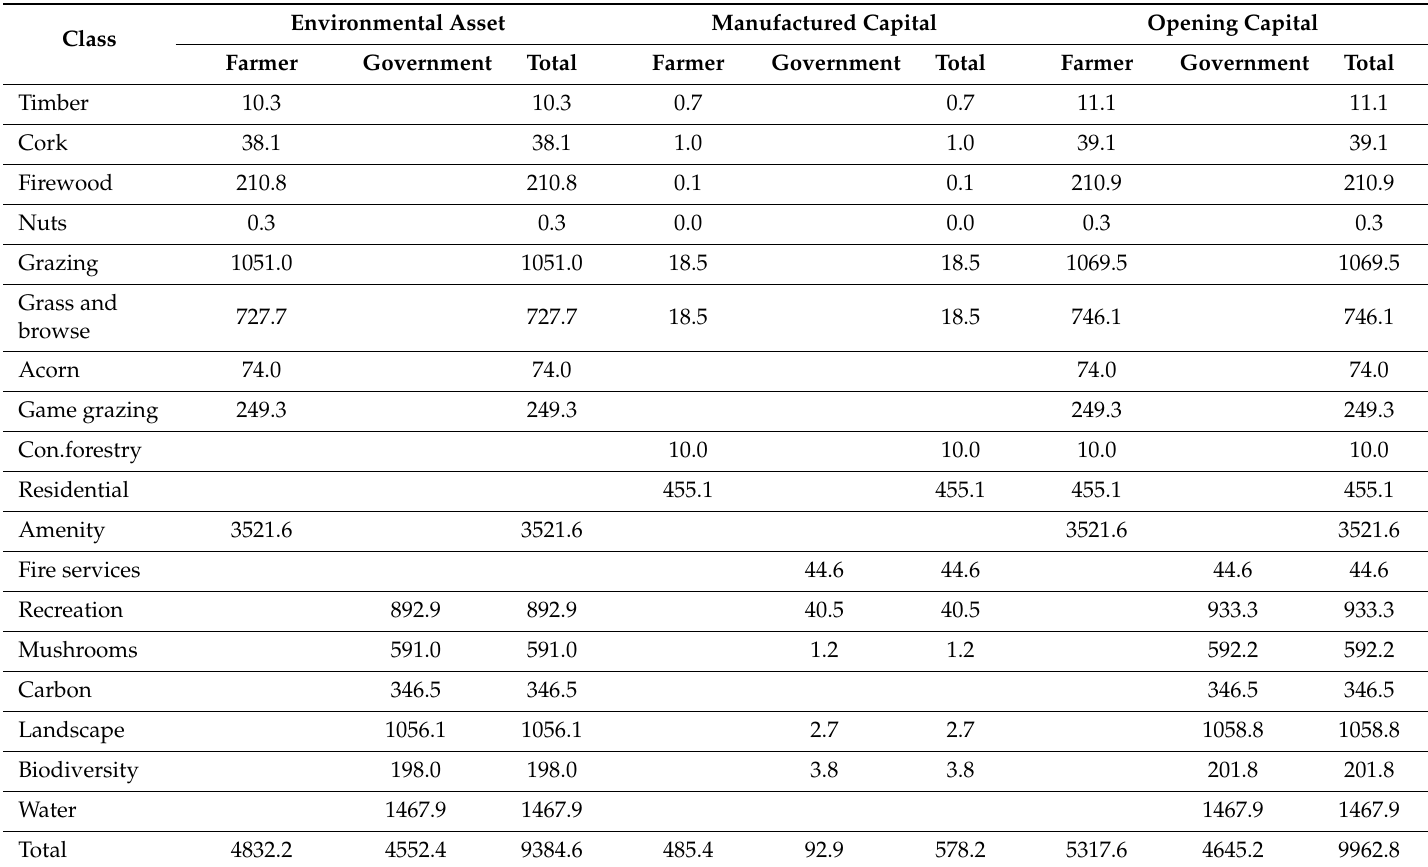
Table 2. Agroforestry Accounting System opening capital of holm oak open woodlands in Andalusia (2010: € /